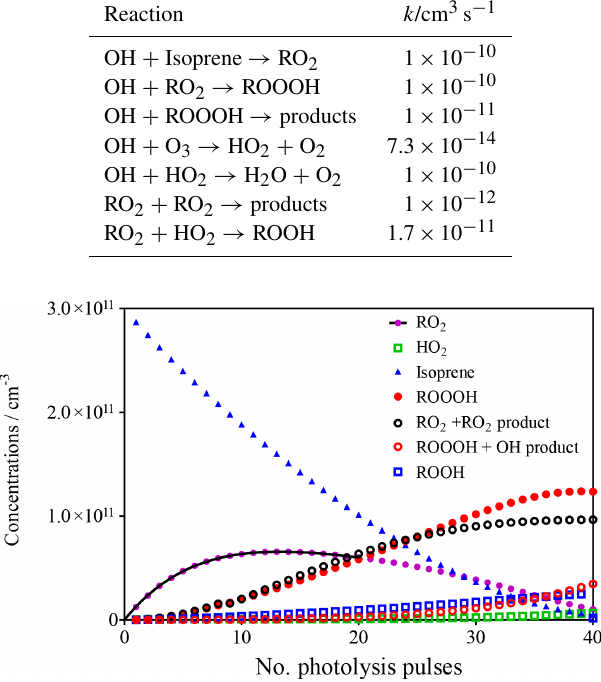
Figure 3. Evolution of different species in the photolysis cell as a function of the number of photolysis pulses. Full black line de- scribes evolution of RO 2 by exponential rise (see section on CH 4